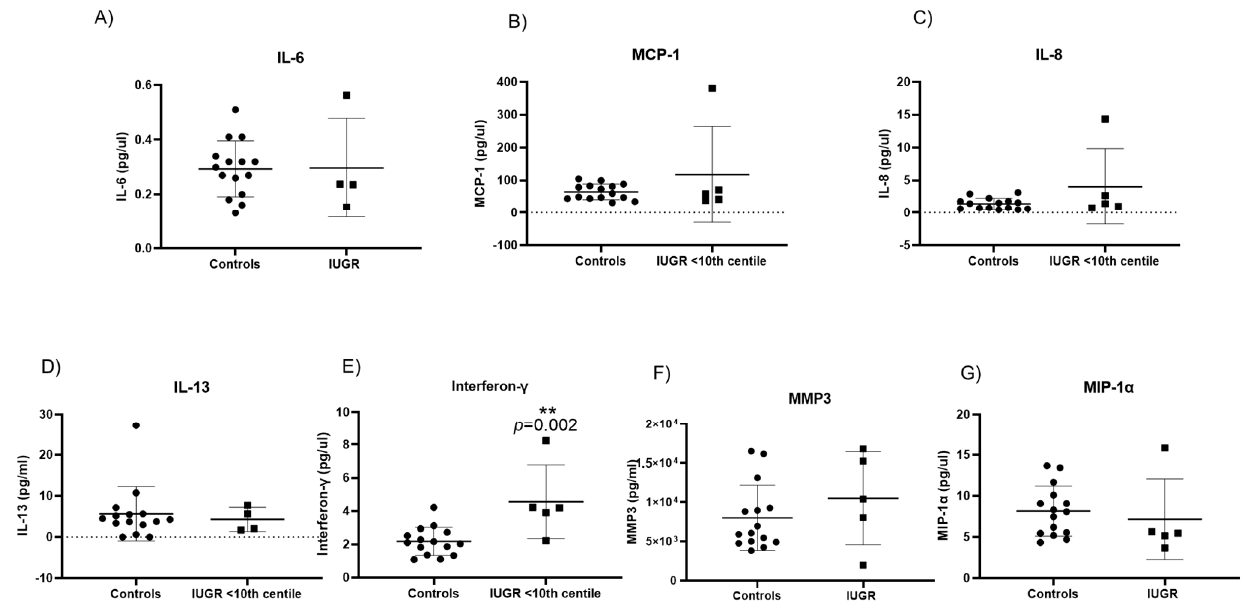
Figure 6. Senescence-associated secretory phenotypes (SASP) in pre-eclampsia with or without intrauterine growth restriction. ( A ) IL - 6 was significantly increased in maternal plasma of pre- eclampsia only pregnancies ( p = 0.017) when compared with controls. All other cytokines: ( B ) MCP - 1, ( C ) IL - 8, ( D ) IL - 13, ( E ) Interferon - γ , ( F ) MMP - 3, and ( G ) MIP - 1 α showed no significant differences between pre-eclampsia subgroups compared with controls. Data are represented as mean ± SD, p < 0.05; p -value < 0.05, it is flagged with one star (*).